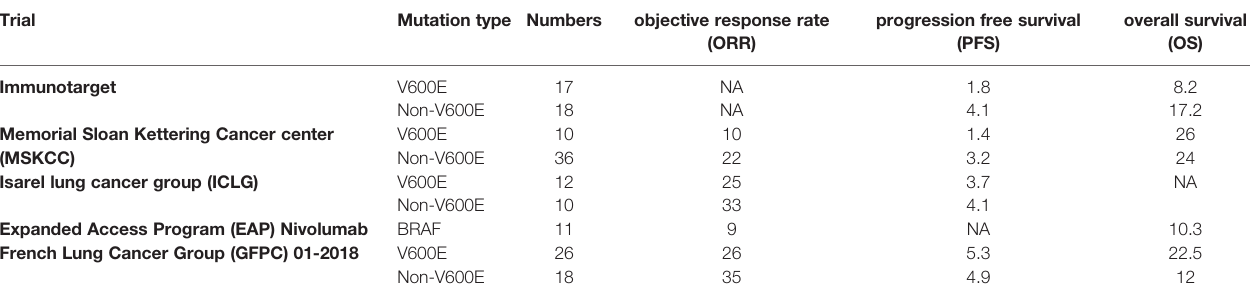
TABLE 1 | ICI monotherapy for BRAF-mutated NSCLC.